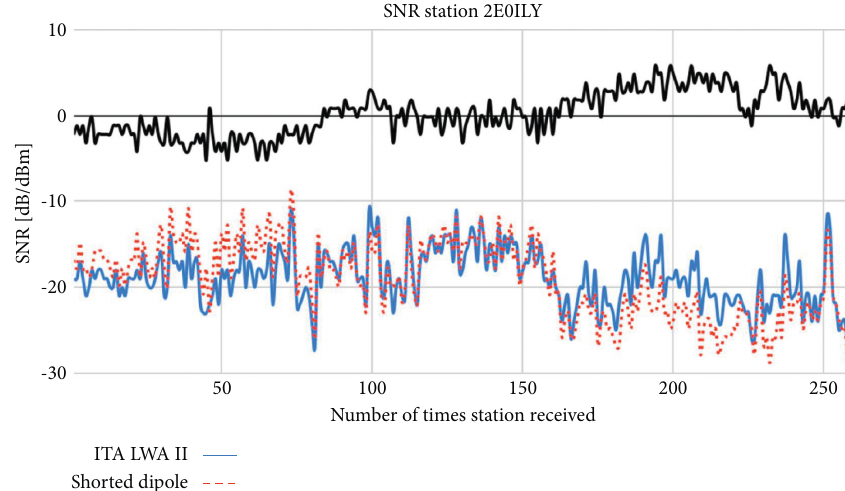
Figure 7: The SNR values of both 160-m antennas for the received station 2E0ILY. Between measurement points 0 and 110, both antennas are in parallel. Between measurement points 110 and 255, the adapted shorted dipole antenna is shifted by 90 ° in the horizontal plane, compared to the ITA LWA II antenna. The solid blue line is the ITA LWA II antenna, and the dotted red line is the adapted shorted dipole. The difference between both SNR values is shown at the top of the chart (solid black